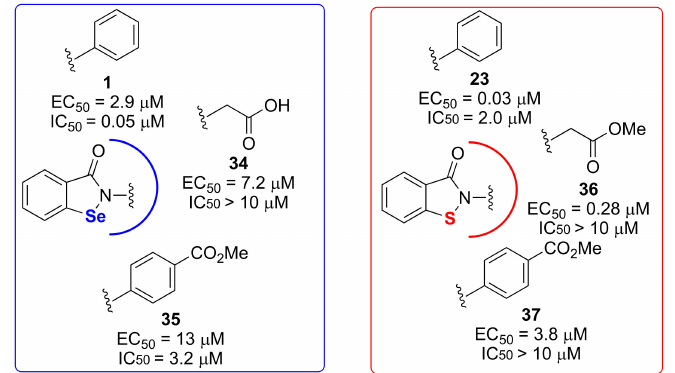
Figure 8. Anti- T. brucei compounds. EC 50 is the ability of compounds to inhibit T. brucei growth while IC 50 is the enzymatic